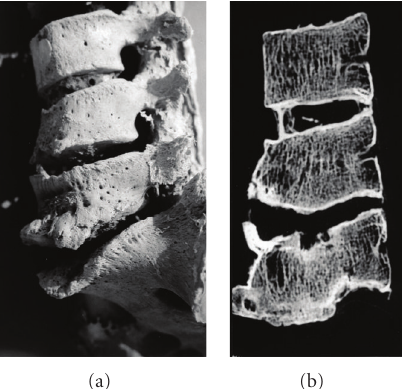
Figure 2: Typical macrophology of spinal tuberculosis with (a) ventral destruction of the a ff ected vertebral bodies and (b) fistular defects of the bone.